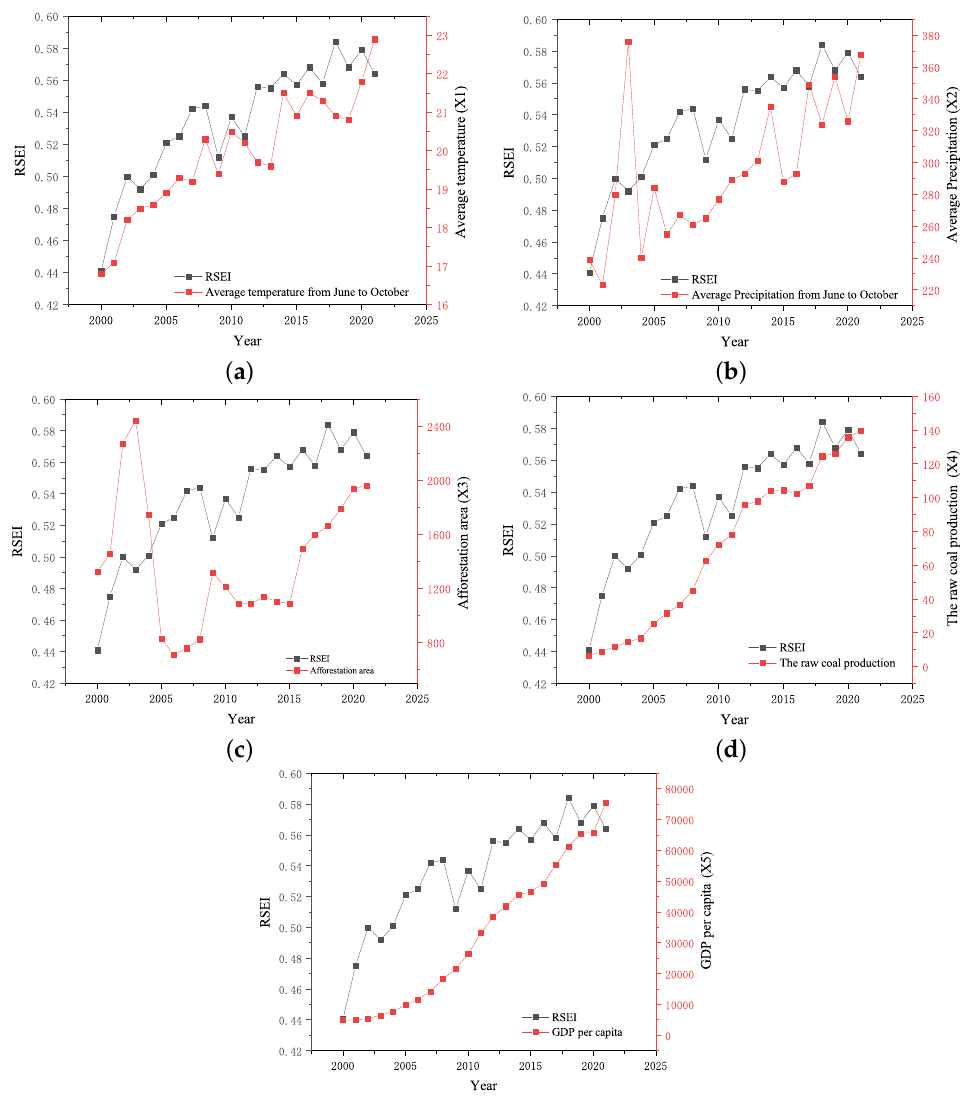
Figure 18. The RSEI and five driving factors (X1–X5) change curve. ( a ) RSEI and average annual temperature, ( b ) RSEI and average annual precipitation, ( c ) RSEI and afforestation area, ( d ) RSEI and raw coal, and ( e ) RSEI and